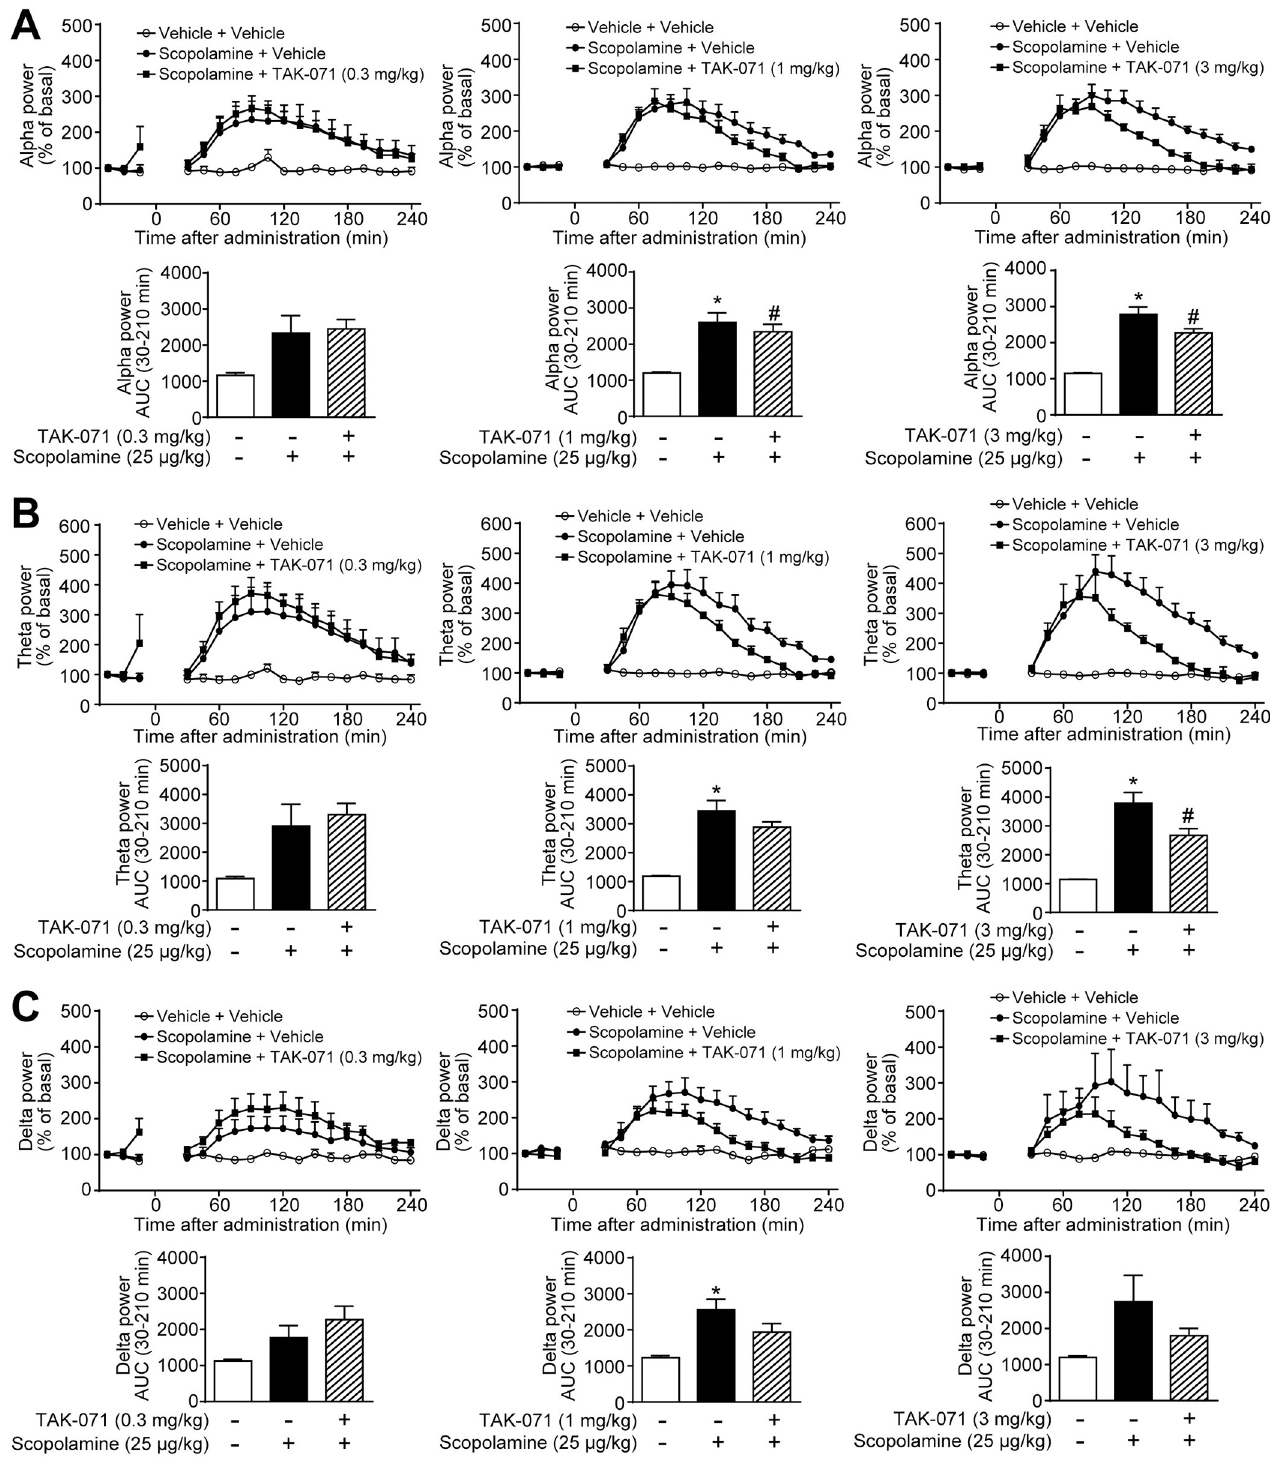
Fig 4. TAK-071 at 0.3–3 mg/kg suppressed the scopolamine-induced qEEG changes. Scopolamine (25 μ g/kg, s.c.) and TAK-071 (0.3–3 mg/kg, p.o.) were simultaneously administered to cynomolgus monkeys. After treatment with drugs or vehicle, (A) alpha, (B) theta, and (C) delta power bands of qEEG spectra were measured from 30 to 240 min. Results represent mean ± SEM of AUC between 30 and 210 min after treatment for 3–4 monkeys in each group. � P � 0.05 versus vehicle-treated group by paired t -test. # P � 0.05 versus scopolamine-treated group by paired t -test. AUC, area under the curve; p.o., oral administration; qEEG, quantitative electroencephalogram; SEM, standard error of the mean; s.c., subcutaneous administration.